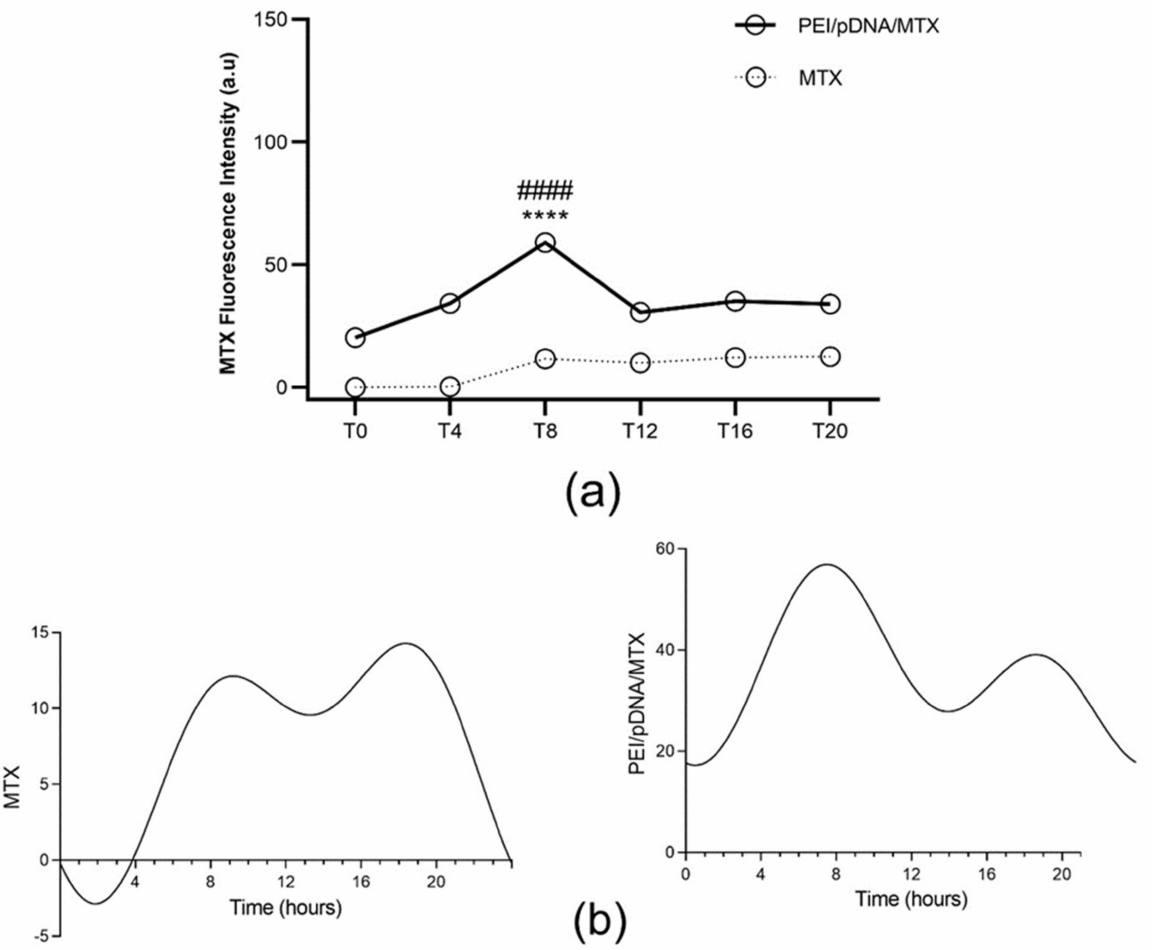
Figure 8. Quantification of cell-associated MTX fluorescence for each time point. ( a ) The fluorescence intensity of MTX was measured in fibroblast cells 6 h after incubation with free MTX or with PEI/pDNA/MTX complexes, at different time points. Each data point represents the mean ± SD (n = 3) and were analyzed by two-way ANOVA with the Bonferroni test. A statistically significant difference was noticed for PEI/pDNA/MTX between T8 and the other groups (**** p < 0.0001). Additionally, the difference between MTX and PEI/pDNA/MTX is statistically significant for all the time points (#### p < 0.0001). ( b ) Circadian oscillations are statistically significant as analyzed with CircWave ( p < 0.001 for both MTX and